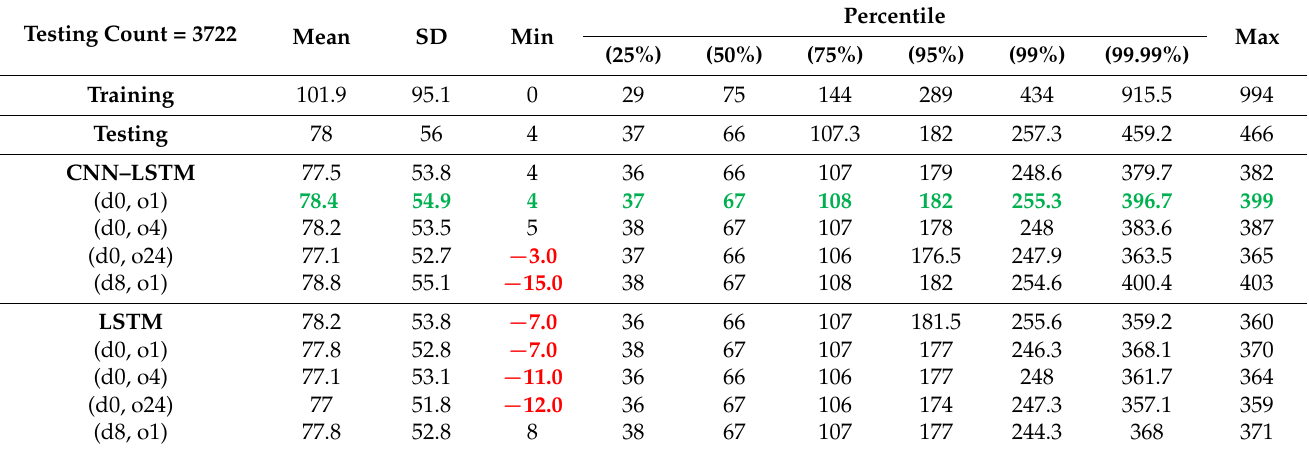
Table 8. Output statistics of CNN–LSTM and LSTM along with NARX vs. training and testing output for the seventh iteration for the Beijing dataset.